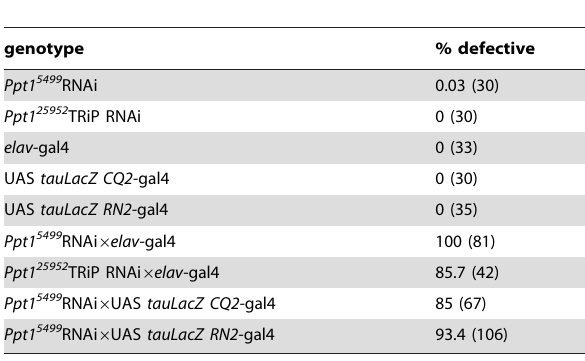
Table 4. Quantitation of Ppt1 RNAi embryos displaying FasII